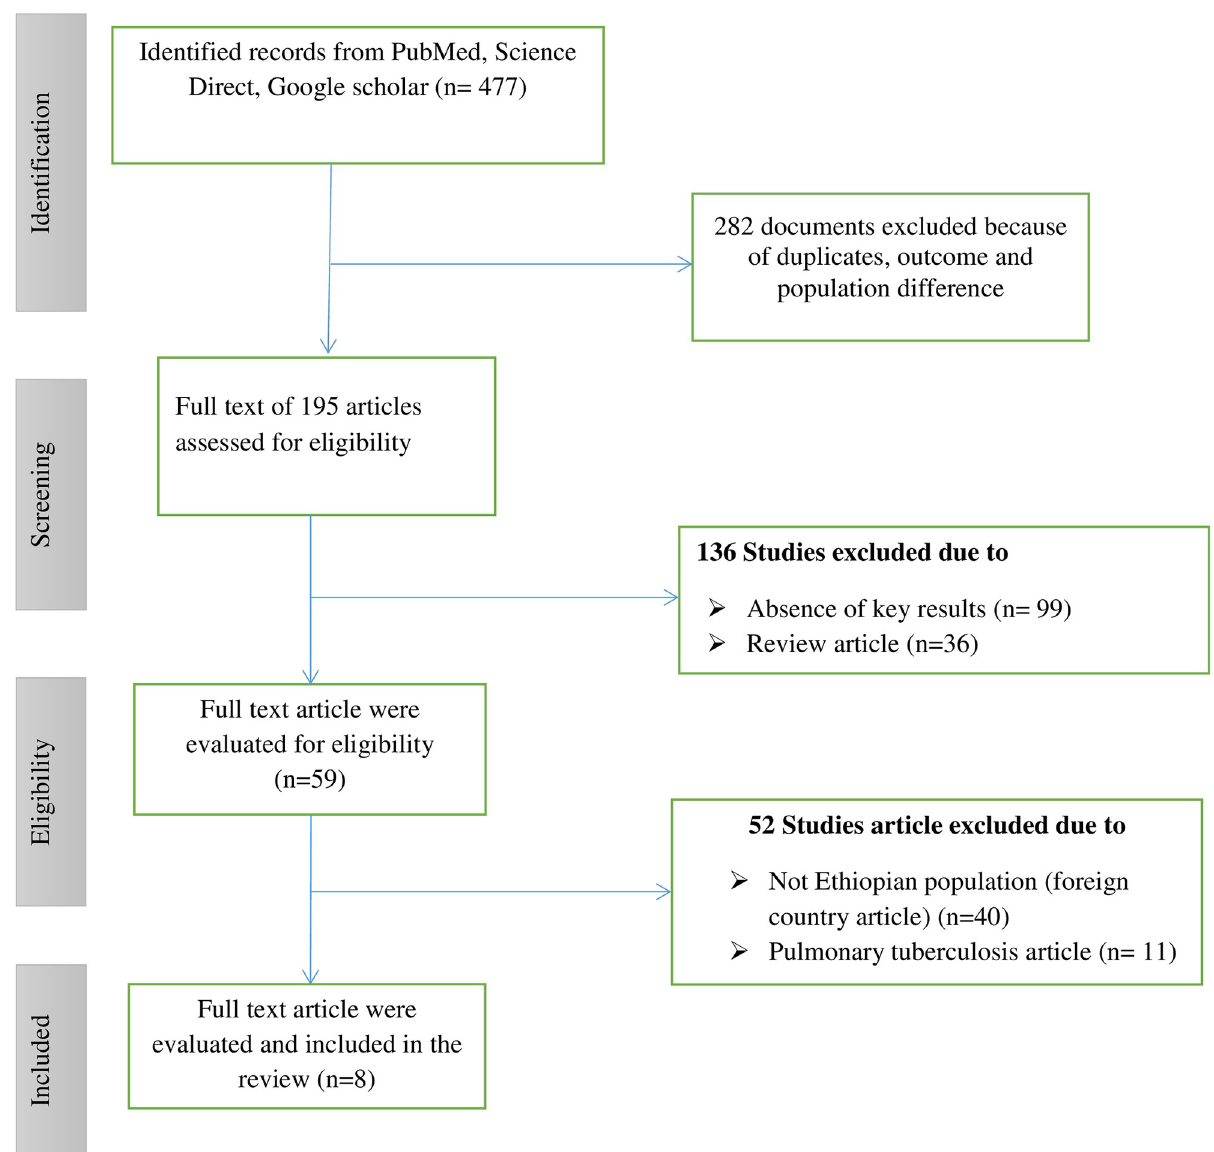
Fig 1. Flow diagram of the study search, selection and screening literature for the review.